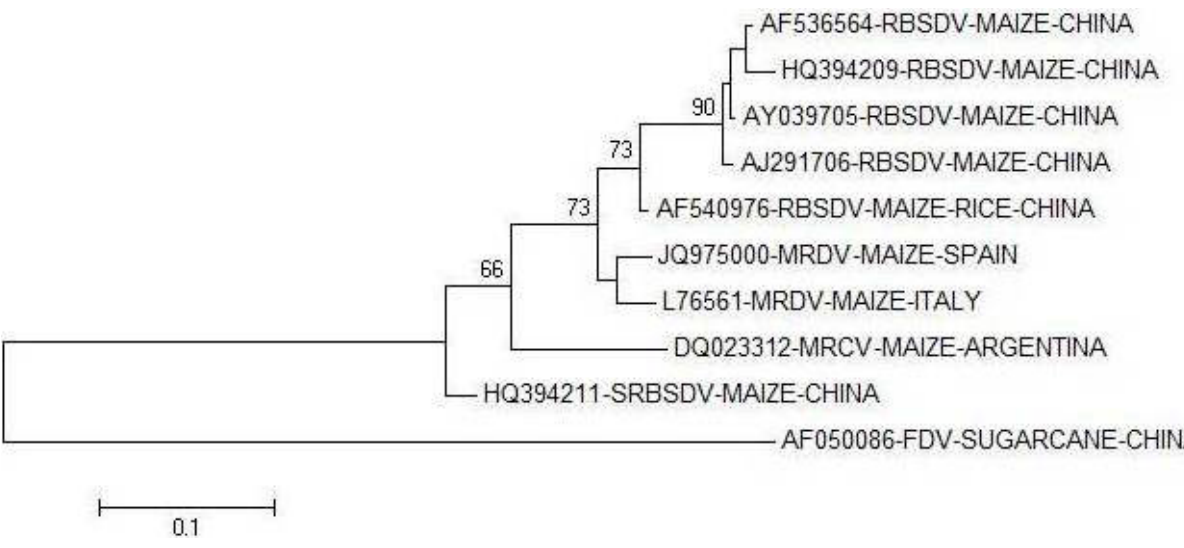
Figure 3. Phylogenetic tree constructed with nucleotide sequences of 3’ non-coding region of segment 9 from Fijivirus that infect maize using the neighbour joining method. The numbers above the branches indicate the frequency of the cluster after bootstrap analysis (1000 replicates). Branches with bootstrap values <50% were collapsed, and only branches with bootstrap values ≥60% are shown.